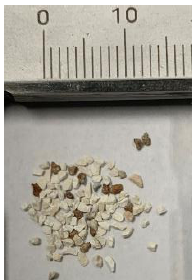
Figure 15. The picture of white particles (Ofunato CaO) and black particles (Ofunato CaO) after decarbonization at 1223 K for 5 h in a muffle furnace.